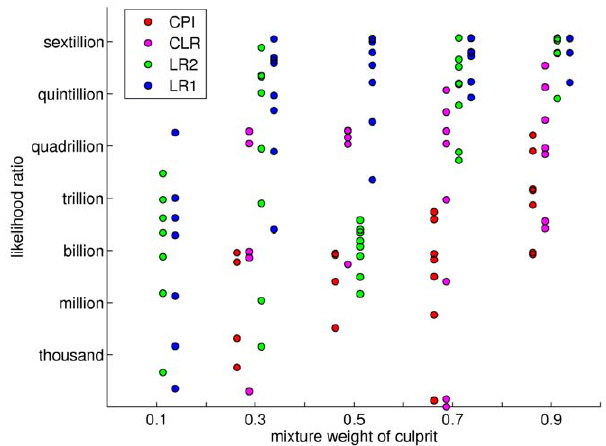
Figure 6. Match information as a function of mixture weight and interpretation method. A scatter plot of log(LR) match information (y-axis) versus culprit mixture weight (x-axis). Each of the five culprit weights (10%, 30%, 50%, 70% and 90%) has four columns, one for each of the mixture interpretation method match statistics (CPI in red, CLR in purple, LR2 in green, and LR1 in blue). In each column, there are up to eight mixture cases; a case is not shown when its log(LR) is